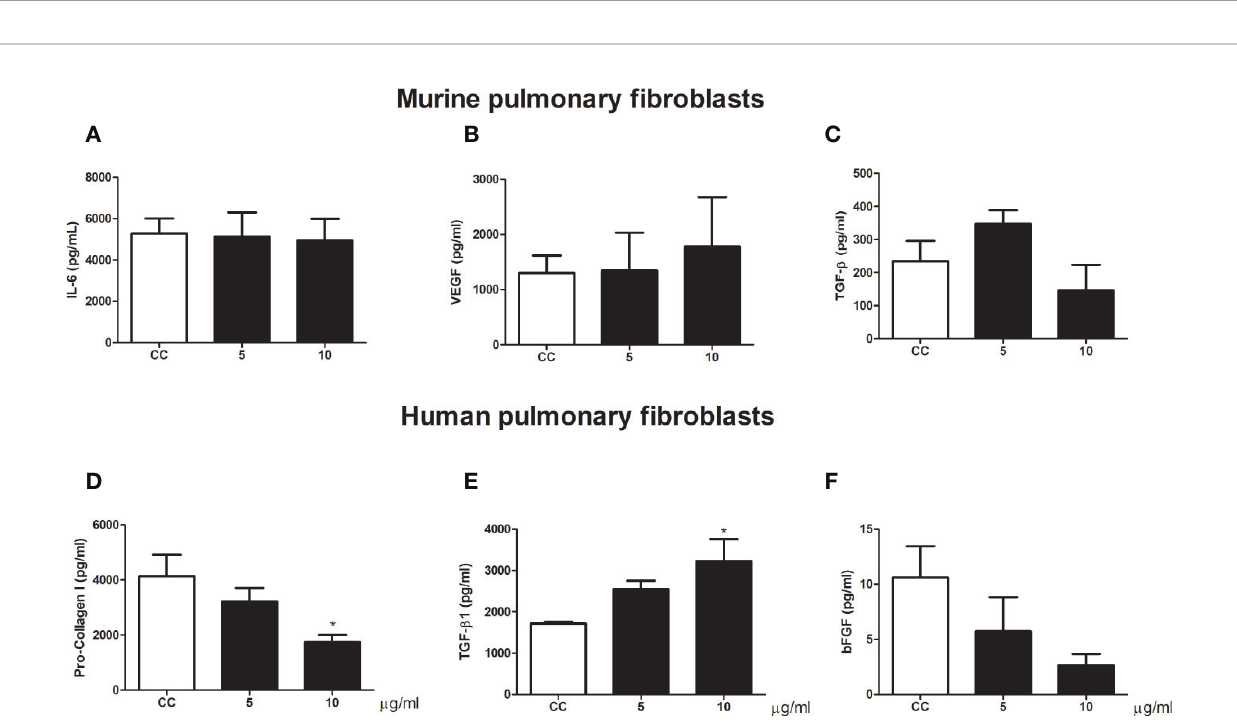
FIGURE 5 | Pulmonary fi broblast activity stimulated by gp43. Human and murine fi broblasts were cultured in the presence or absence of gp43 and IL-6, VEGF, TGF- b 1, pro-collagen I, and bFGF levels in the cell-free supernatants were determined 24 h post-treatment. (A) IL-6. (B) VEGF. (C) TGF- b 1. (D) Pro-collagen I. (E) TGF- b 1. (F) bFGF. Results are expressed as means ± SEM; ANOVA with Dunnett ’ s post hoc test; * p < 0.05; n =